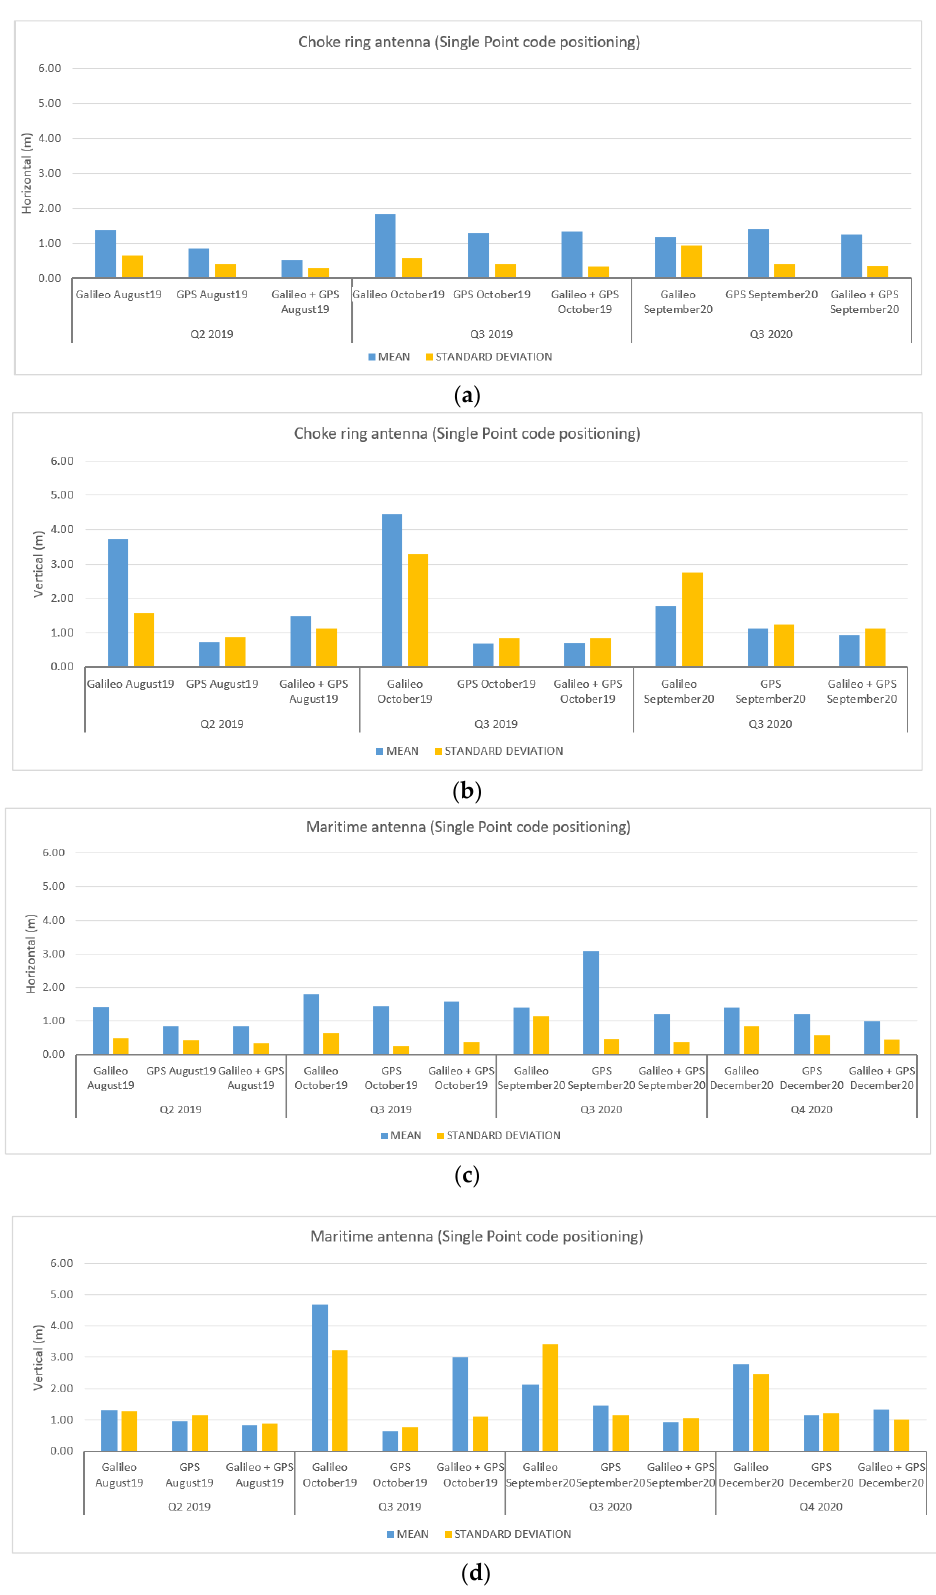
Figure 16. Horizontal and vertical mean values and standard deviations (in meters) for the SPP code solutions in maritime environments, using CSRS-PPP as reference for: ( a ) horizontal and ( b ) vertical for the choke ring antenna; ( c ) horizontal and ( d ) vertical for the maritime antenna.